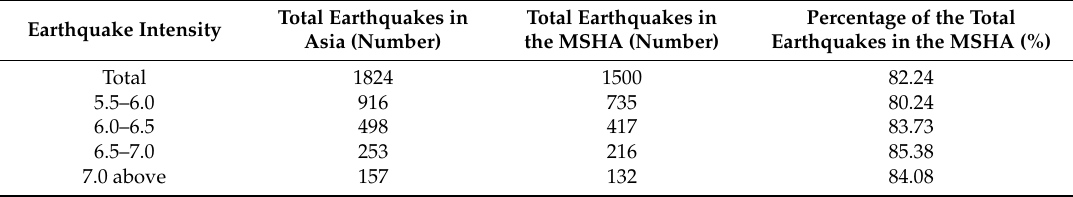
Table A4. Earthquake events in the MSHA between 1900 and